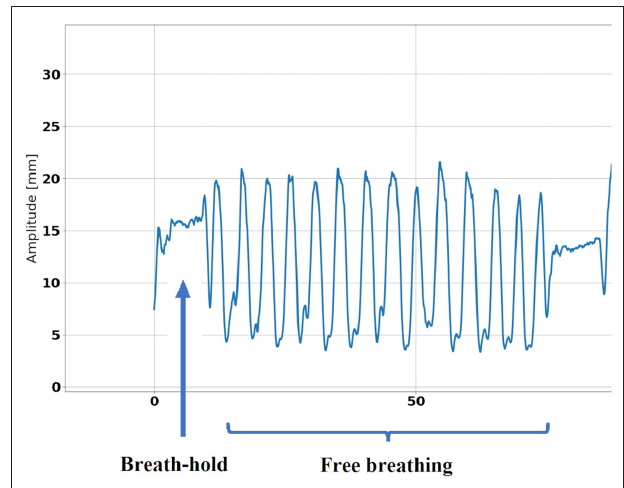
FIGURE 4 | Example of heart displacement measured by ultrasound during respiratory